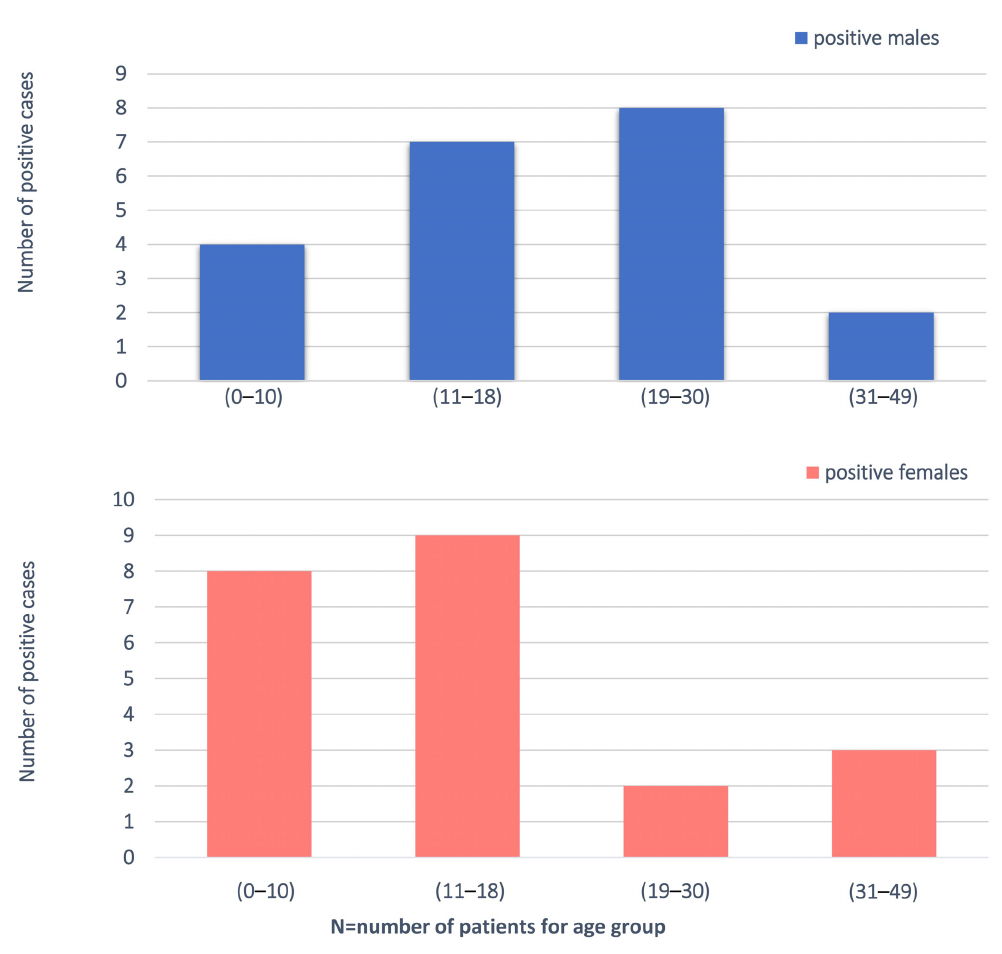
Figure 1. Demographic analysis of the cohort, filtered by age and gender.